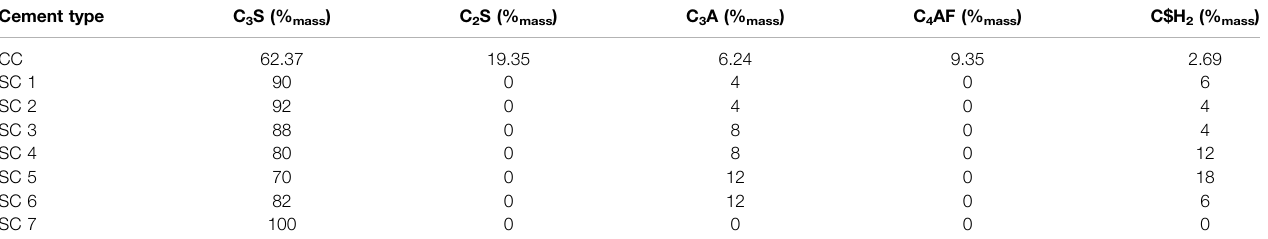
TABLE 1 | Compositions of commercial cement (CC) and synthetic cements (SCs) 1 – 7.